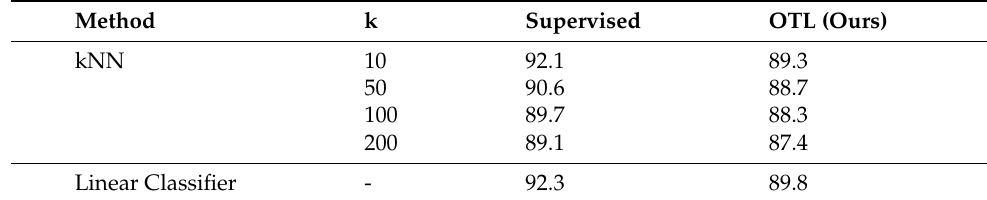
Table 12. NWPU RESISC45.